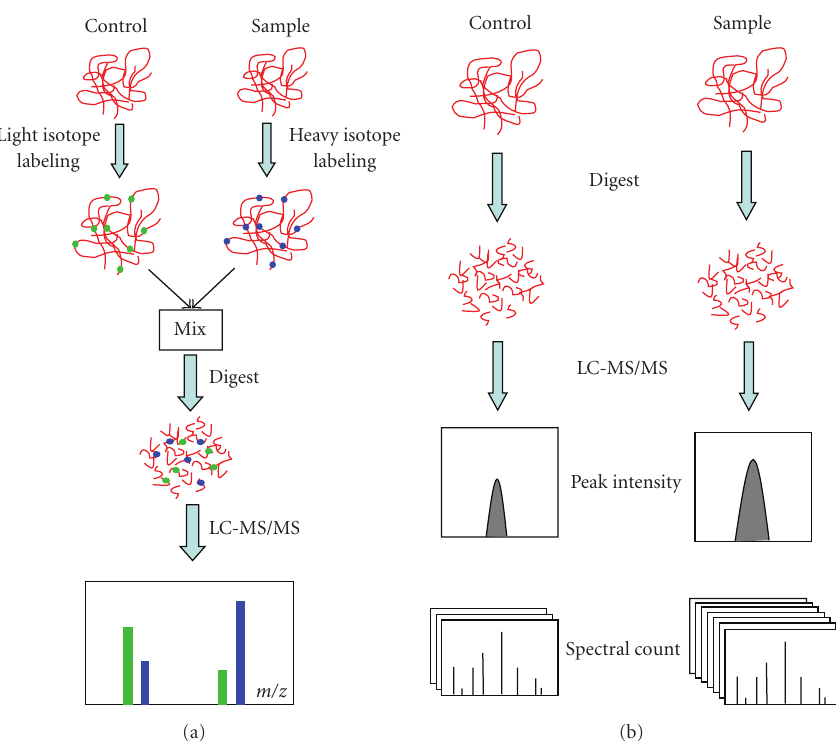
Figure 1: General approaches of quantitative proteomics. (a) Shotgun isotope labeling method. After labeling by light and heavy stable isotope, the control and sample are combined and analyzed by LC-MS/MS. The quantification is calculated based on the intensity ratio of isotope-labeled peptide pairs. (b) Label-free quantitative proteomics. Control and sample are subject to individual LC-MS/MS analysis. Quantification is based on the comparison of peak intensity of the same peptide or the spectral count of the same protein.